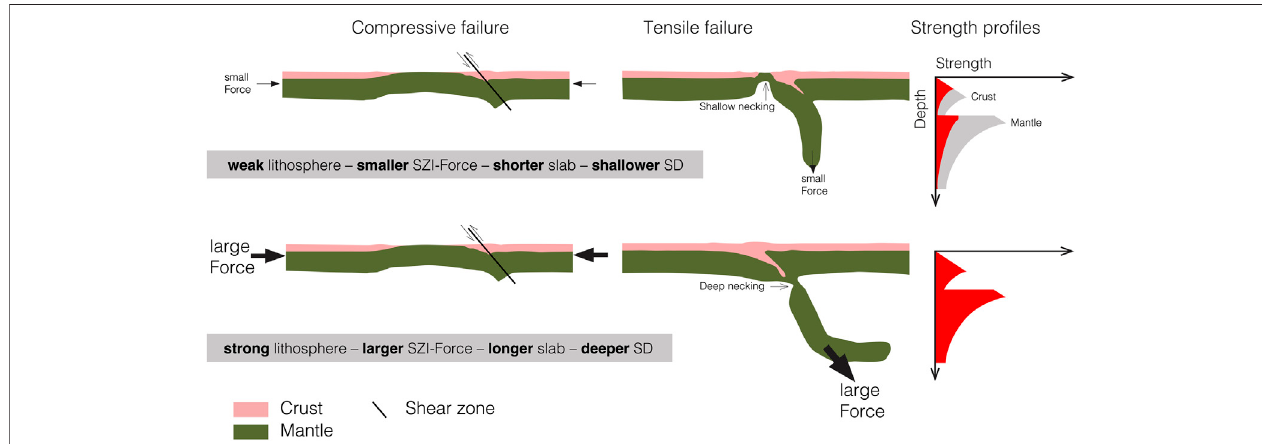
FIGURE 10 | Simpli fi ed sketch illustrating the causal link between plate strength, forces required for subduction zone initiation (SZI) and slab detachment (SD) depth. Pink colours indicate the crust, olive green colours the mantle, the red colour in the strength pro fi les represents a schematic yield strength envelope of the crust and the mantle for a given depth and the black solid lines represent shear zones. Compared toa weak plate, a strong plate requires higher forces for SZI, yields a longer slab and slab detachments at larger